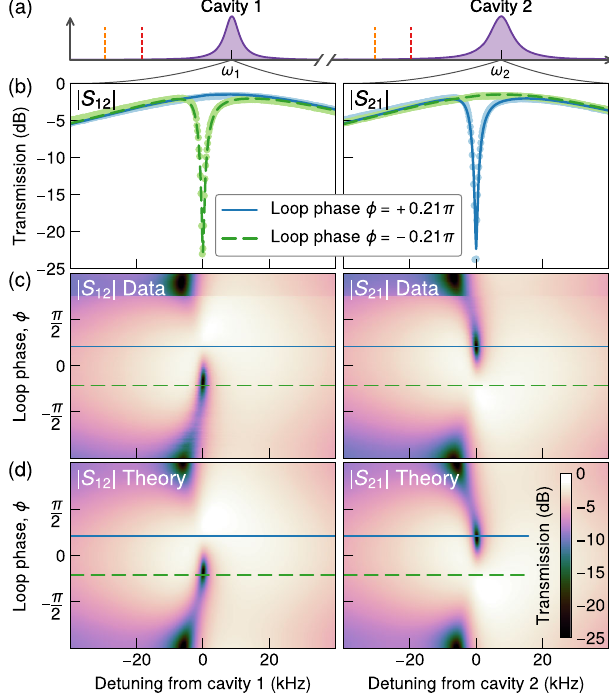
FIG. 3. Optomechanical isolation. (a) Frequency space dia- gram. Four drives (dashed lines) induce frequency conversion between the two cavities through both mechanical modes simul- taneously. (b) Measured magnitude of transmitted signal received at cavity 1 (left) and cavity 2 (right) for two choices of loop phase. At ϕ ¼ þ 0 . 21 π (solid blue) signals are transmitted from cavity 2 to cavity 1 and attenuated in the reverse direction. The behavior reverses at ϕ ¼ − 0 . 21 π (dashed green line). Solid lines are fits to the expanded coupled-mode theory model described in the text. (c) Transmission (color scale) as a function of detuning and loop phase. Lines show the source of data shown in (b). (d) Result of the least-squares fit of the two-dimensional data in